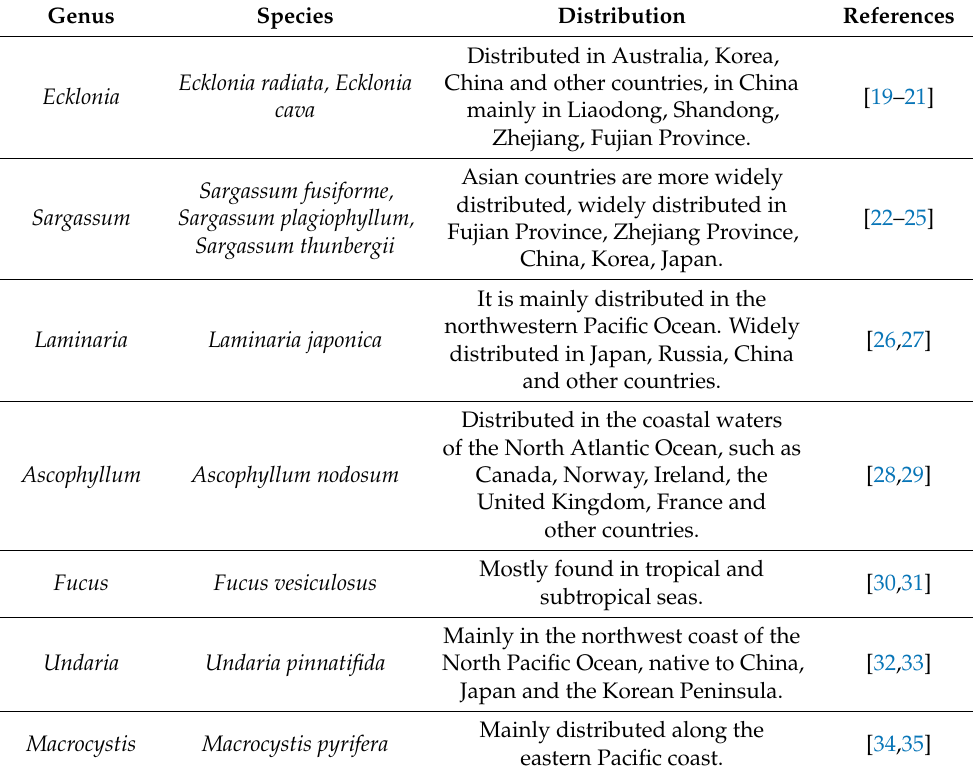
Table 1. The main species and distribution of brown algae with protective effects on the intestine. Genus Species